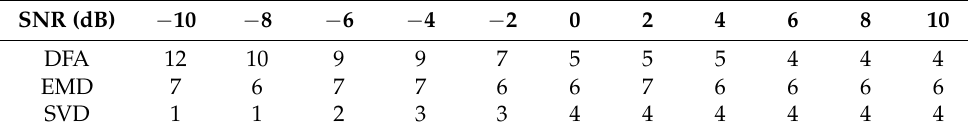
Table 1. Comparison of the SVD with DFA and EMD for solving K .